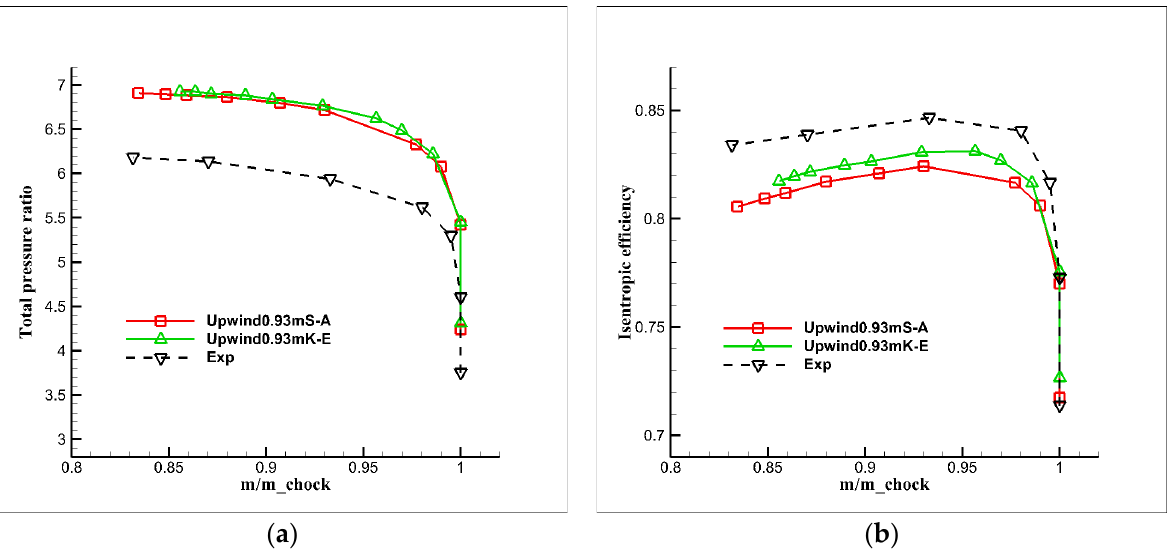
Figure 5. Compressor performance curves generated under different turbulence models. ( a ) Total pressure ratio. ( b ) Isentropic efficiency. pressure ratio. ( b ) Isentropic efficiency.